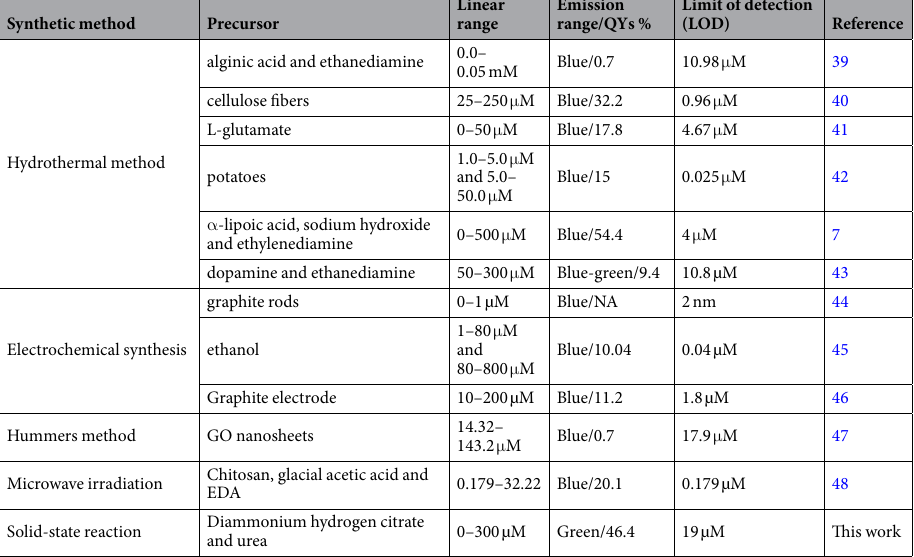
Table 1. Analytical performances of recent reported sensors for the detection of Fe 3 + .